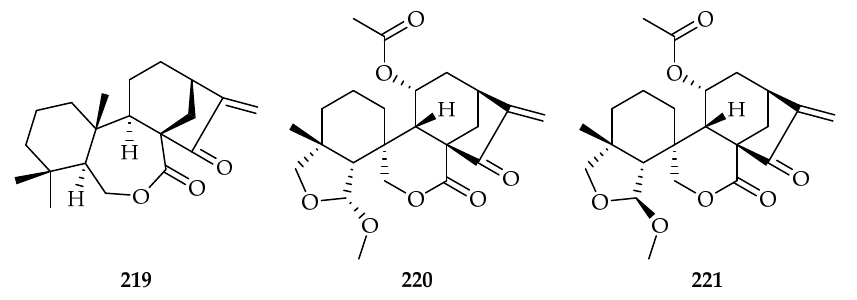
Figure 86. Structures of scapanacin A 219 [134] , 6- epi -11- O -acetylangustifolin 220 [135], and 11- O - acetylangustifolin 221